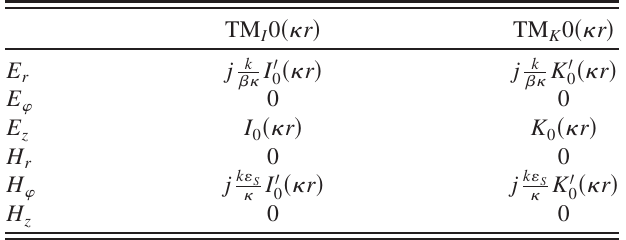
TABLE I. Monopole field components.